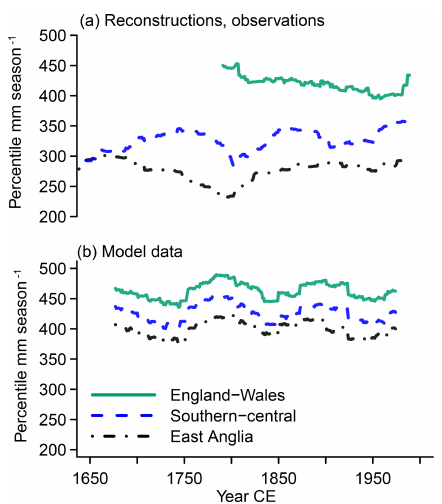
Figure 4. Visualization of the MAMJJ precipitation amount iden- tified as severely wet (percentile 93.3) over 51-year windows for England–Wales (green solid lines), southern–central England (blue dashed lines), and East Anglia (black dash-dotted lines) in (a) re- constructions, observations, and (b)